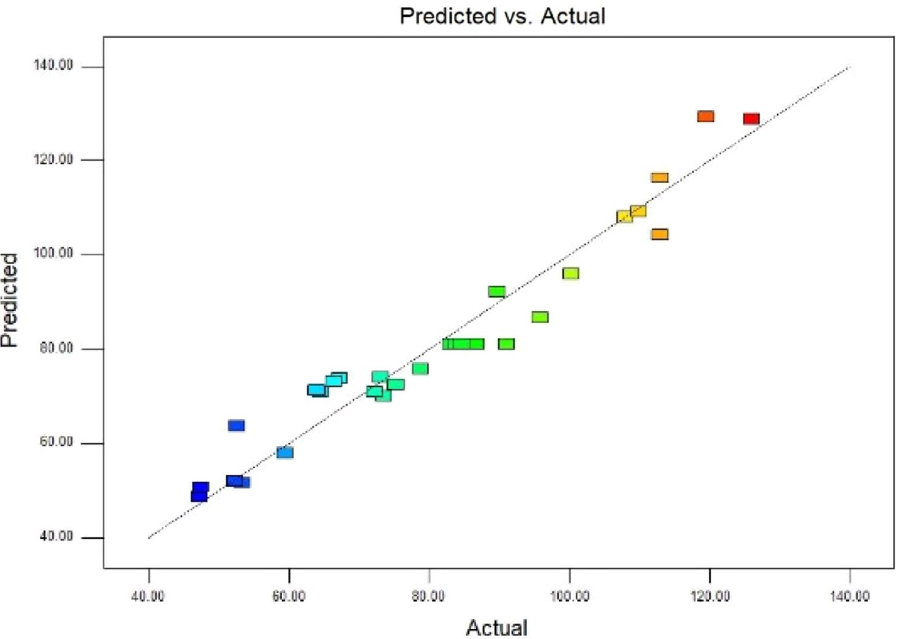
Figure 2. Experiments data vs predicted values for adsorption capacity fitted by design expert